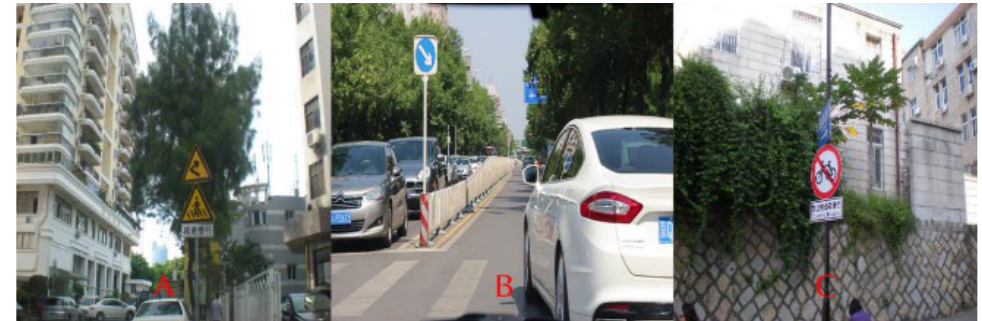
Figure 8. Sample images of the CCTSDB2021 dataset, containing ( A ) warning traffic signs; ( B ) mandatory traffic signs; ( C ) prohibitory traffic signs.